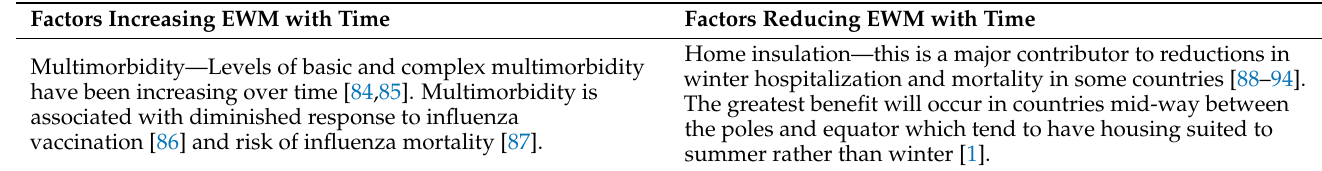
Table 1. Factors increasing or decreasing EWM with